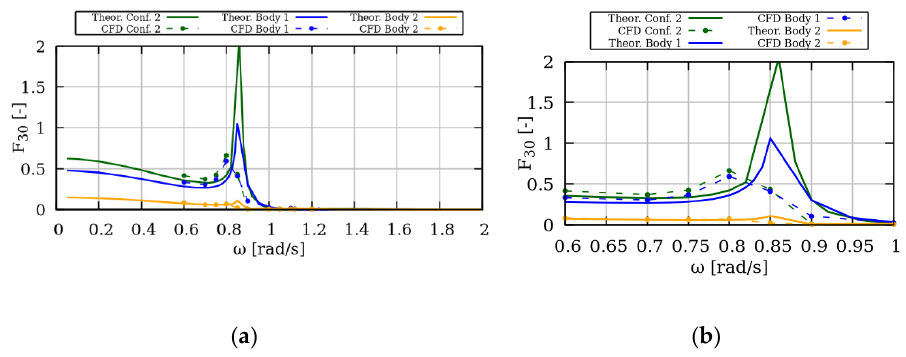
Figure 12. Comparison between the theoretical and CFD results of the non ‐ dimensional vertical excitation force, in case of the Configuration 2; ( a ) wave frequencies 0.05 and 2 rad/s; ( b ) wave frequencies between 0.6 and 1.0 rad/s (detailed view).